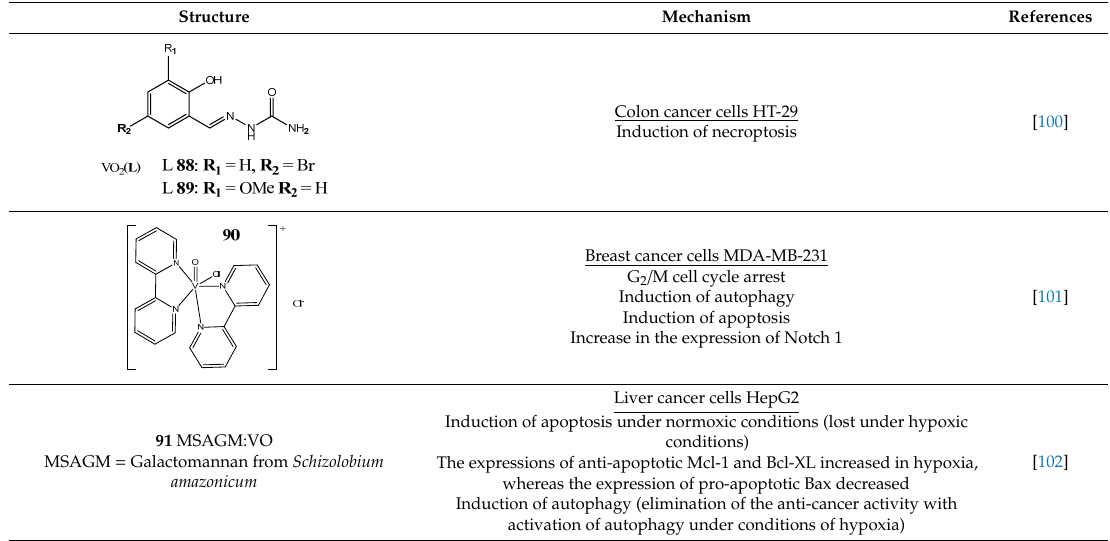
Bold and Underline: makes Table more readable.